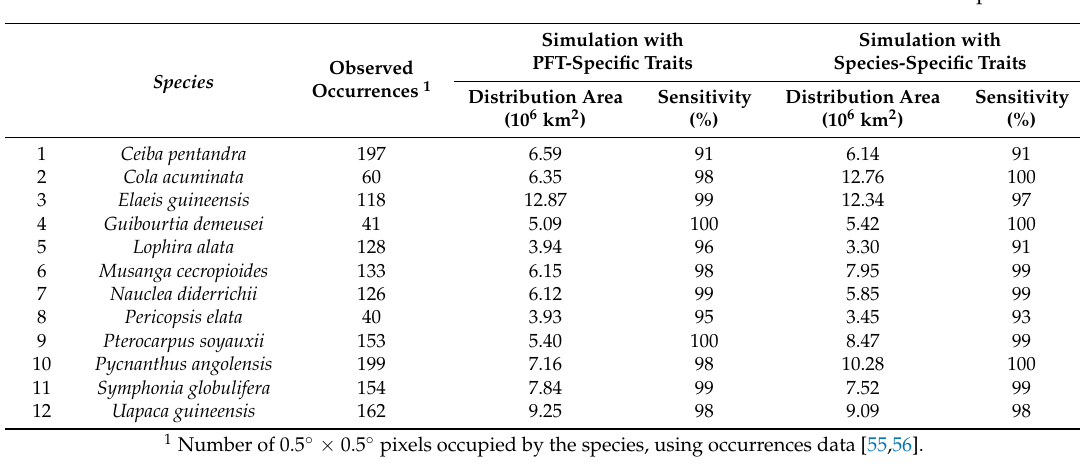
Table 4. Observed species occurrences, species distribution area (10 6 km 2 ) delimited by the by the model) for both simulations using respectively PFT- and species-specific morpho-physiological traits. Simulations were obtained with CRU historical climatic data for the reference 1980–1999 period.